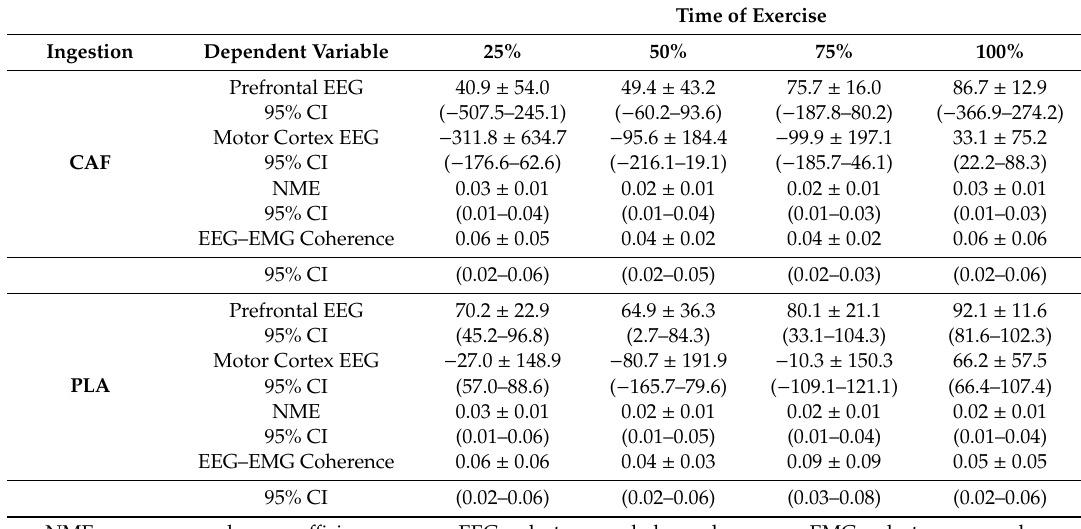
Figure 5. EEG–EMG coherence in CAF (filled square) and PLA (open square) sessions. Data are reported as mean ± SD. Table 1. Mean (±SD) and 95% confidence interval (95% CI) for dependent variables.